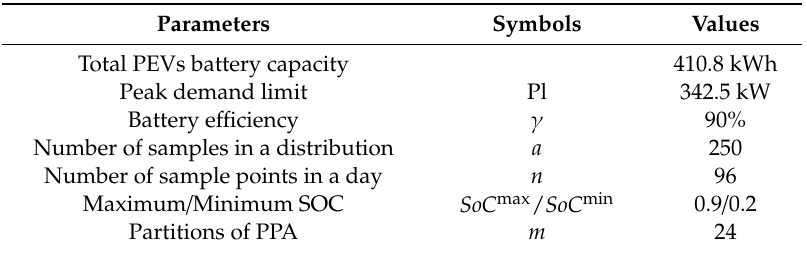
Table 1. Simulation design parameters.